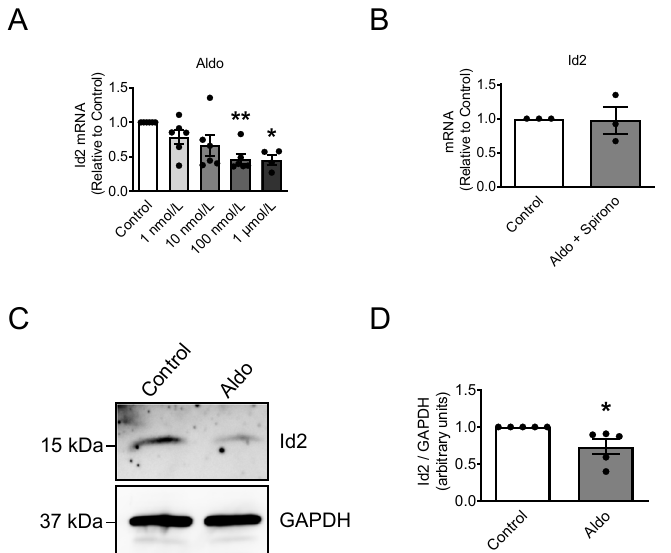
Figure 1. Aldosterone reduce the Id2 expression in neonatal rat ventricular cardiomyocytes. Neonatal rat cardiomyocytes were stimulated with ( A ) Aldo (aldosterone) or ( B ) 1 µmol/L Aldo + Spirono (Spironolactone) for 24 h. Bar graphs show the Id2 ′ s mRNA level in aldosterone (Aldo)-treated and nontreated cardiomyocytes. Id2 mRNAs were measured by real-time qPCR analysis ( n = 6 for ( A ) and n = 3 for ( B )). ( C ) Representative pictures of western blot experiments showing the Id2 protein (upper) and Glyceraldehyde 3-phosphate dehydrogenase (GAPDH) protein (lower) expression levels in neonatal rat ventricular cardiomyocytes treated with 1 µmol/L aldosterone (Aldo) for 24 h. ( D ) The bar graph indicates the mean +/ − s.e.m. of Id2 protein expression in aldosterone (Aldo)-treated (1 µmol/L) and non-treated cardiomyocytes from five independent experiments. The data were evaluated by one-way analysis of variance (ANOVA) followed by Tukey–Kramer’s post hoc test or by unpaired two-tailed Student’s t -test. Bar graphs are mean and + s.e.m, * p < 0.05, ** p < 0.01.